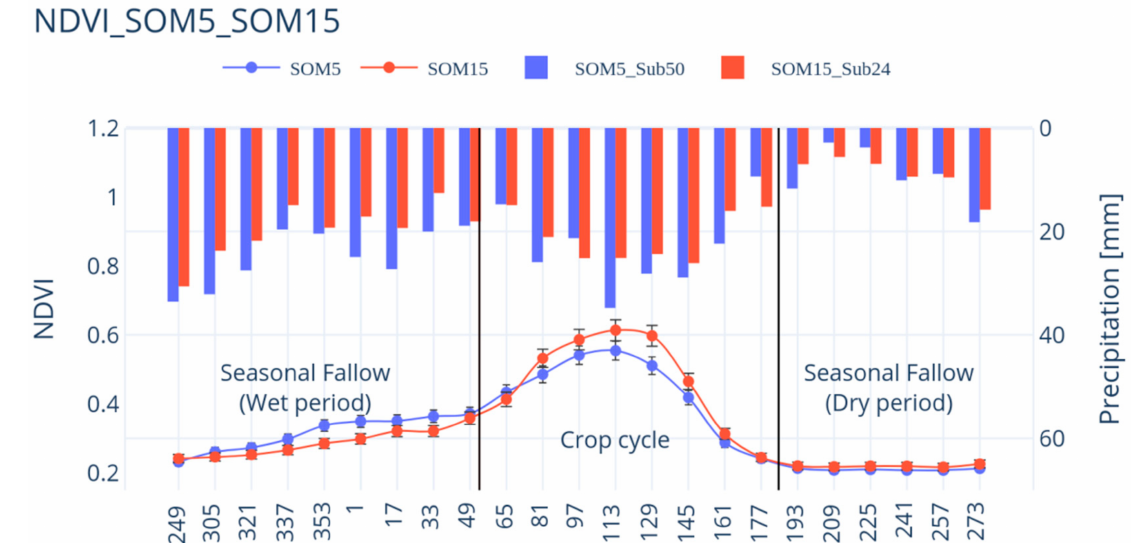
Figure 5. Average of NDVI for each DOY and for monoculture cereals crop cycle of SOM5 and SOM15 in comparison with precipitation (bars) for the period 2000 to 2019. The x -axis indicates Day of the Year (DOY) and the cycle starts in October as the same as hydrological cycle in Spain.